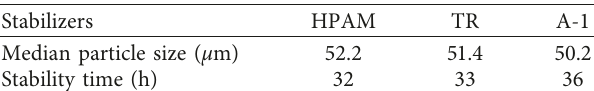
Figure 3: Effect of stirring speed on particle size and stability time of the temporary plugging agent. Table 6: Influence of the stabilizer on particle size and stability time of the temporary plugging agent.